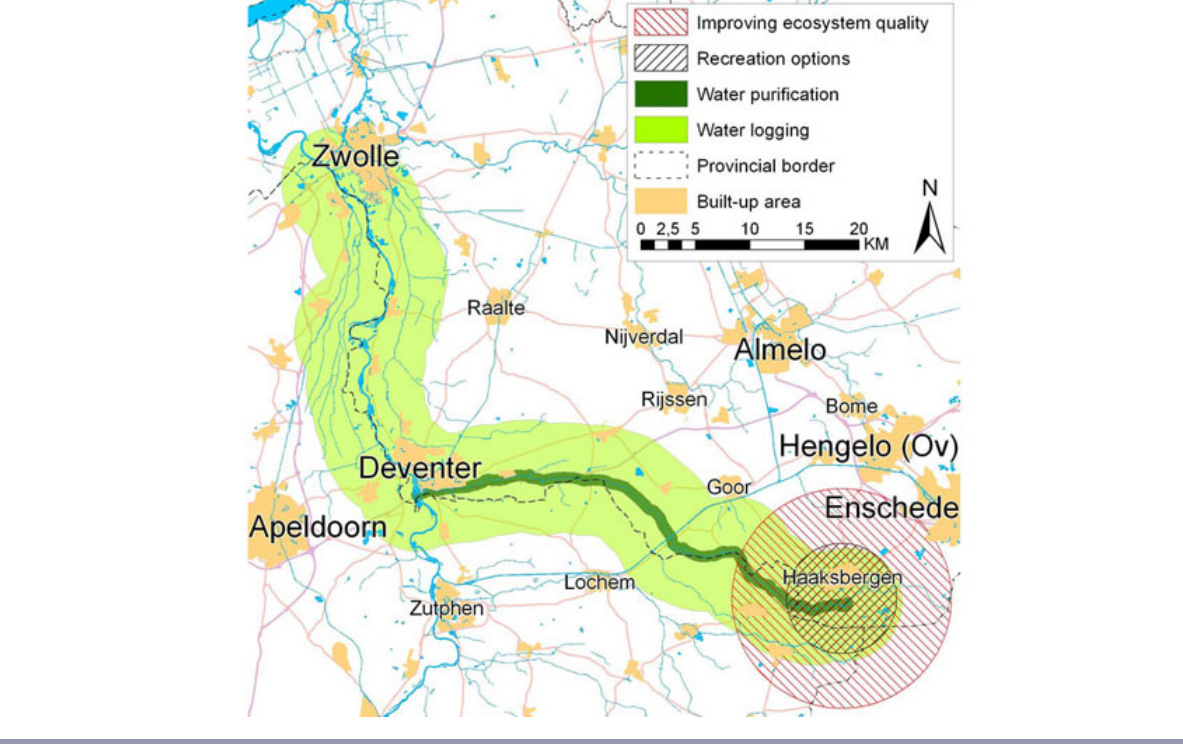
Fig. 2. Spatial ecosystem service scale and spatial beneficiaries scale per commercial wetland